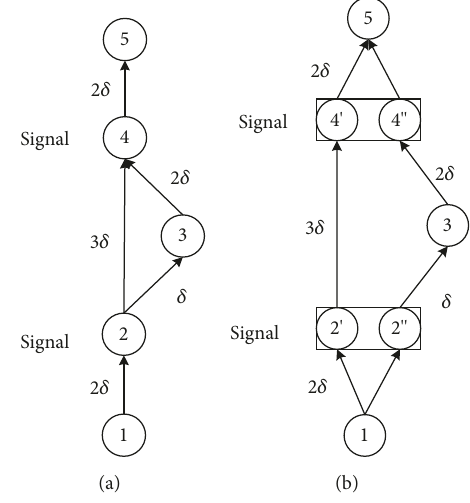
Figure 4: An illustrative